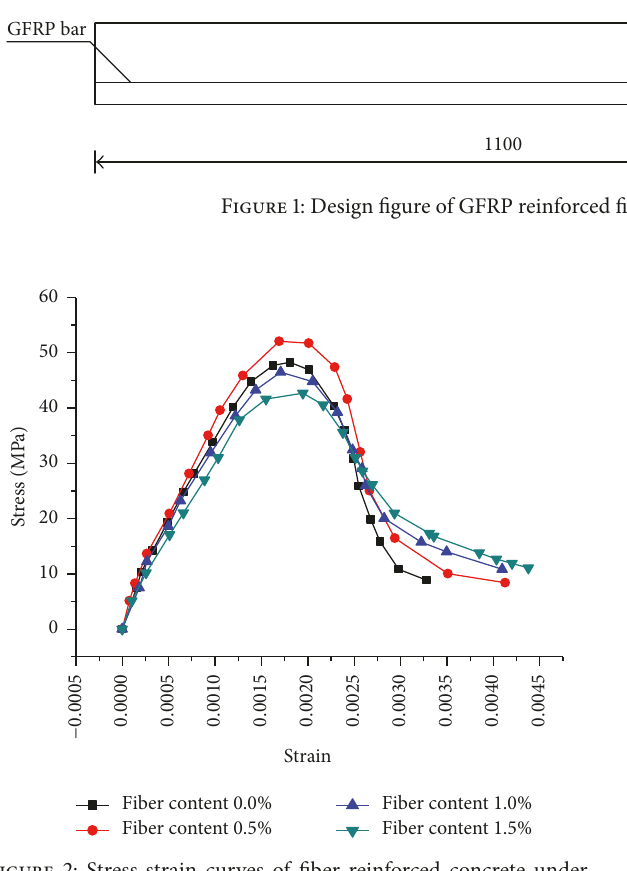
Figure 2: Stress-strain curves of fiber reinforced concrete under uniaxial compression.